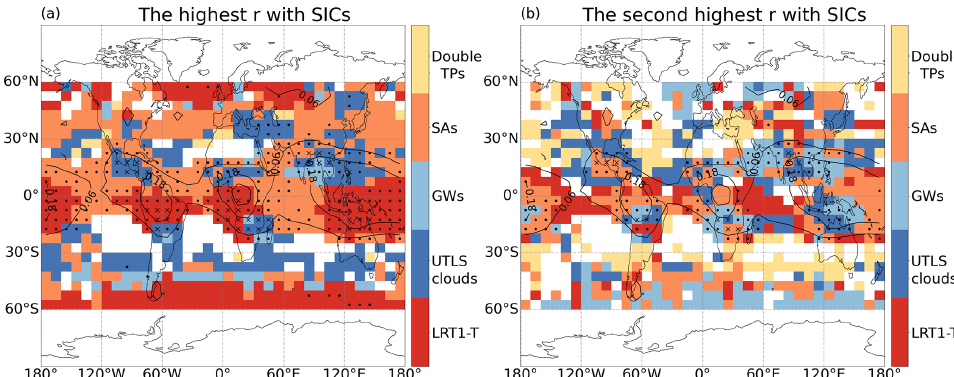
Figure 10. The highest and second-highest correlation coefficients between SIC occurrence frequency and all processes (LRT1-T, UTLS clouds, gravity waves (GWs), stratospheric aerosols (SAs), and double tropopauses (double TPs)). Only grid boxes with absolute r ≥ 0 . 3 are presented, and grid boxes with a dot have 0 . 6 ≤ absolute r < 0 . 8, while grid boxes with a cross ( x ) have 0 . 8 ≤ absolute r < 1 . 0. Black contours are the occurrence frequencies of